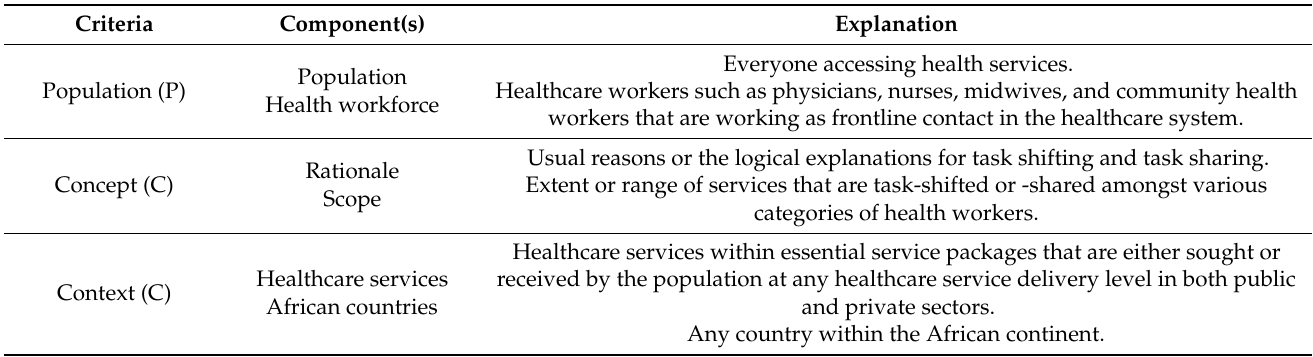
Table 1. Population, concept, and context (PCC) framework for the scoping